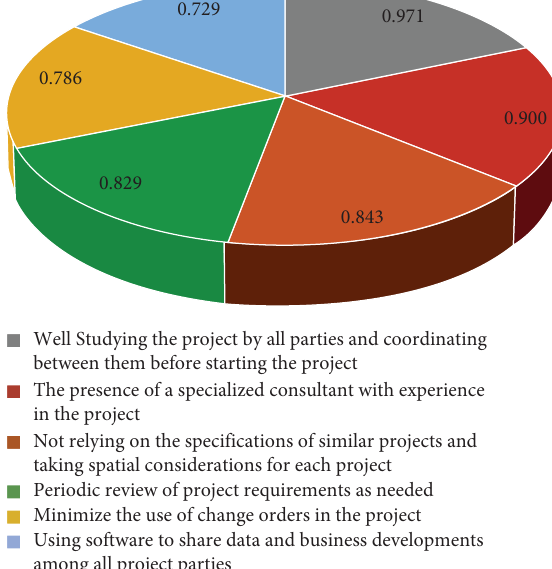
Figure 8: )e most important factors that mitigate the impacts of change orders (overall